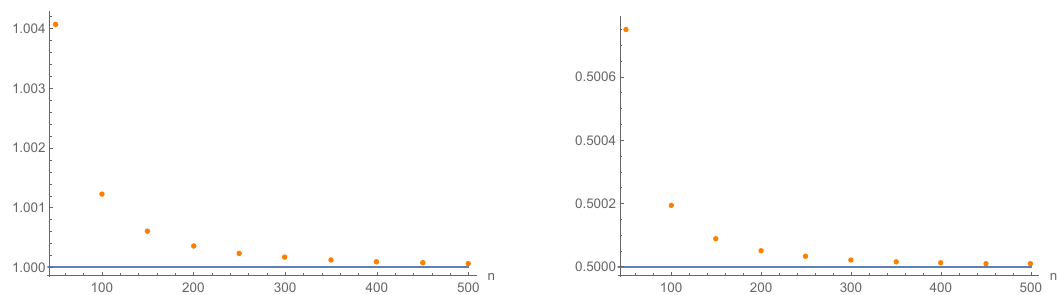
Figure 1 . Plots for the coe(cid:14)cient of (cid:22) 3 ; (cid:22) 5 from the series expansion with Pad(cid:19)e approximation, as one increases the truncated length of the